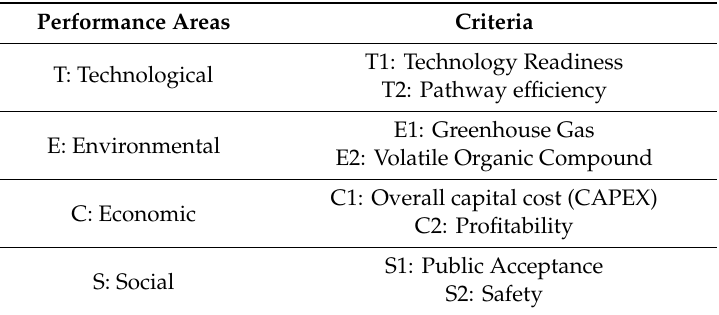
Table 4. Analytic Hierarchy Process Comparison Criteria.